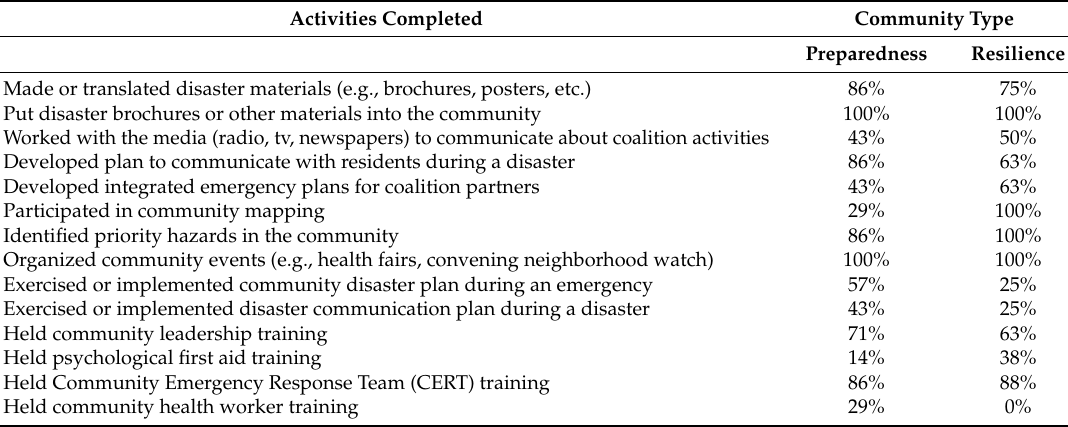
Table 2. Reported Activities by Coalition Type and